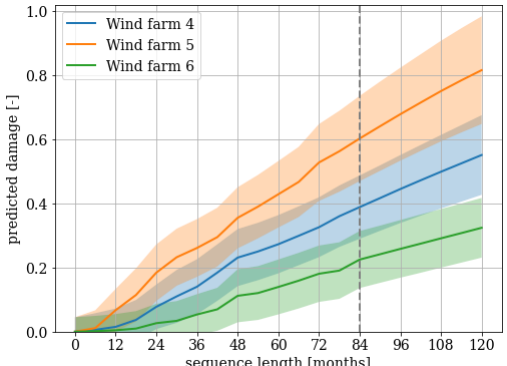
Figure 14. Sequence length sensitivity : example of the predicted damage progression for three different wind farms for varying se- quence lengths and zero initial damage. Each sequence begins on 1 January